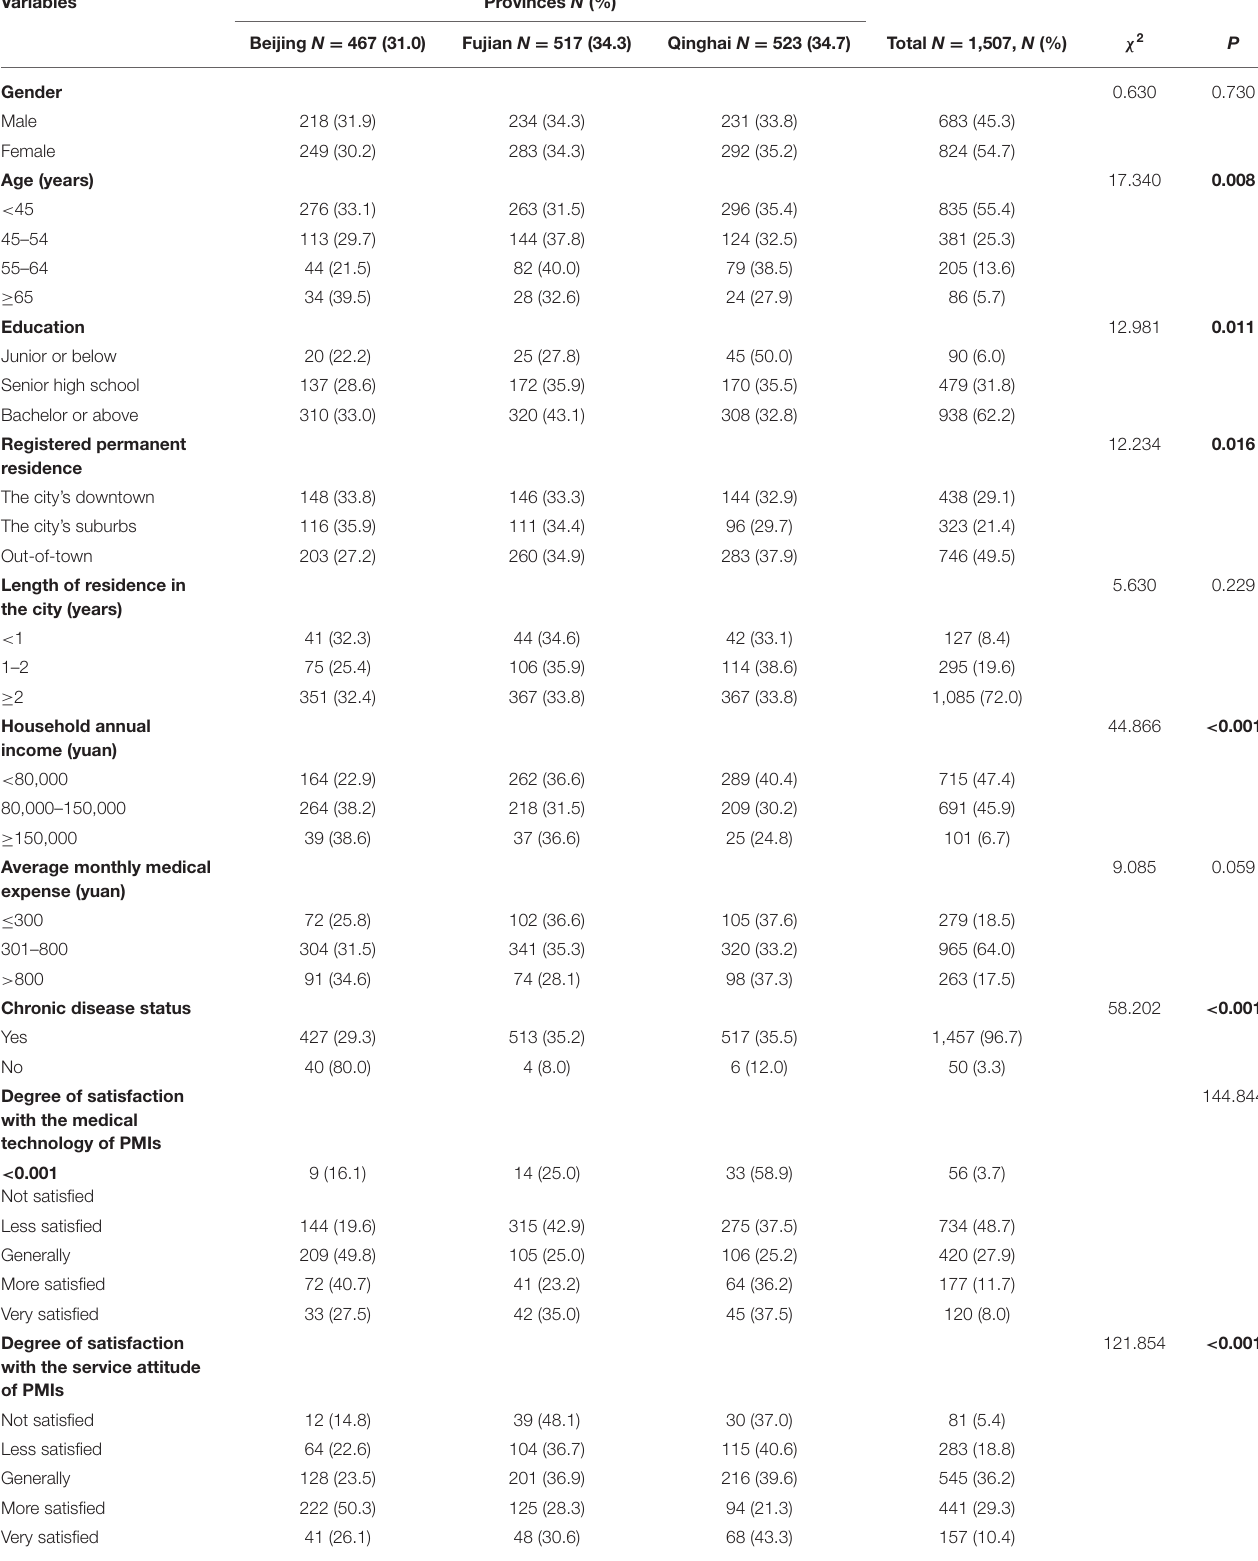
TABLE 3 | Univariate analysis of patients’ sociodemographic, attitudes and understanding of relevant policies in different provinces.